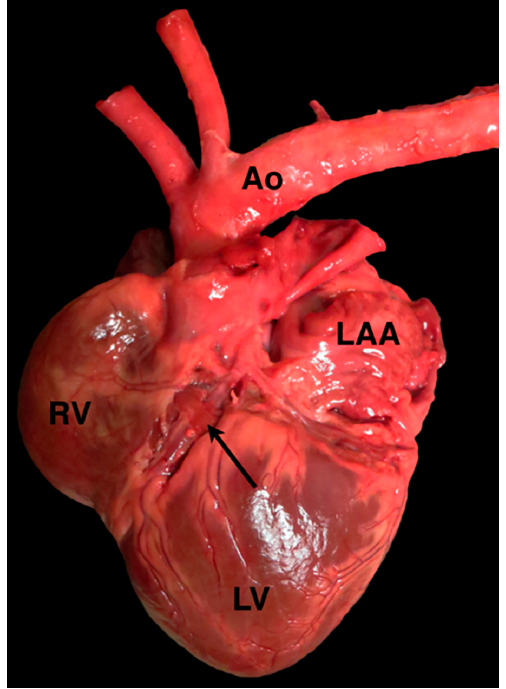
Figure 11. A photograph of a myocardial bridge (arrow) covering a portion of the left paraconal interventricular branch of the left coronary artery in a dog. Ao = aorta, LAA = left auricular appendage, LV = left ventricle, RV = right ventricle.